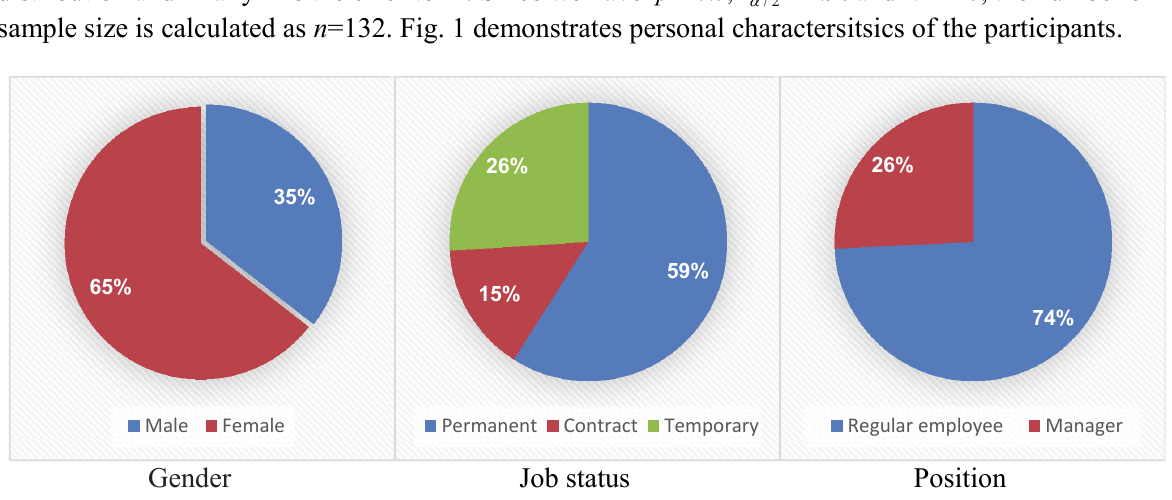
Fig. 1. Personal characteristics of the participants